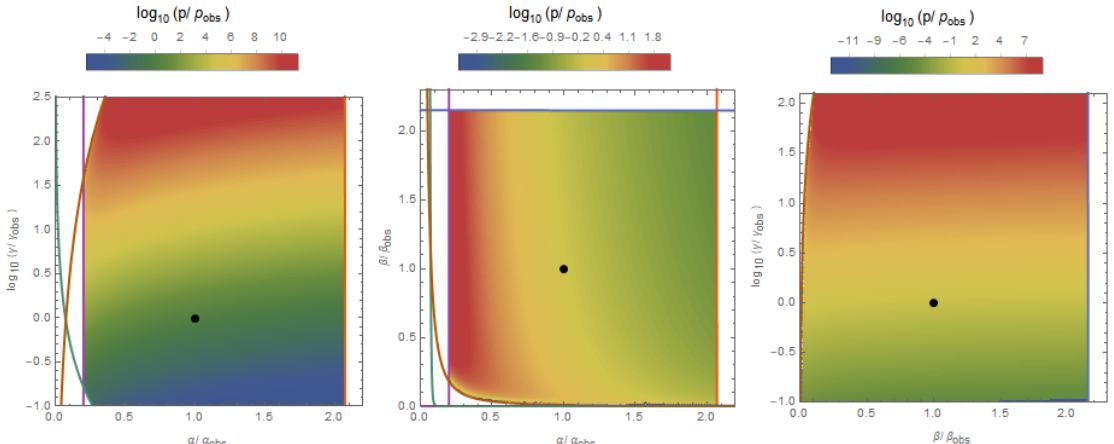
Figure 1. The distribution of observers when taking metallicity effects into account, in the α – γ , α – β , and β – γ subplanes. What is plotted is the logarithm of the probability of measuring any value of the coupling constants, with red being more probable than blue, and the black dot corresponding to our observed values. Included thresholds are an upper bound on α for hydrogen stability, as well as a lower bound for galactic cooling, and an upper bound on β for proton–proton fusion. The teal and brown curves correspond to the metallicity and supernova lifetime thresholds, respectively, and the supernova retention threshold is not relevant in this